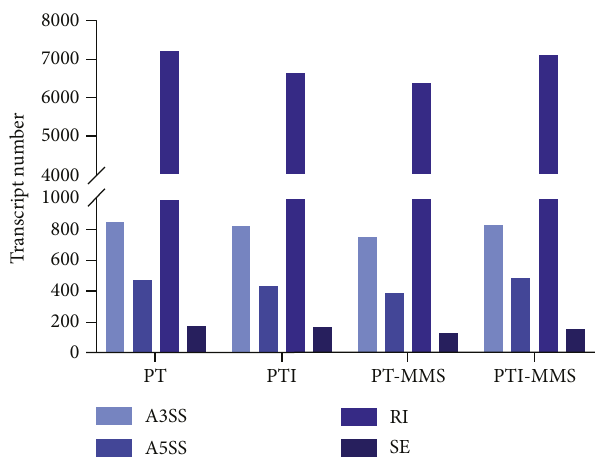
Figure 7: Alternative splicing events in Paulownia. A3SS: alternative 3 ′ splice site AS events; A5SS: alternative 5 ′ splice site AS events; RI: intron retention; ES: exon